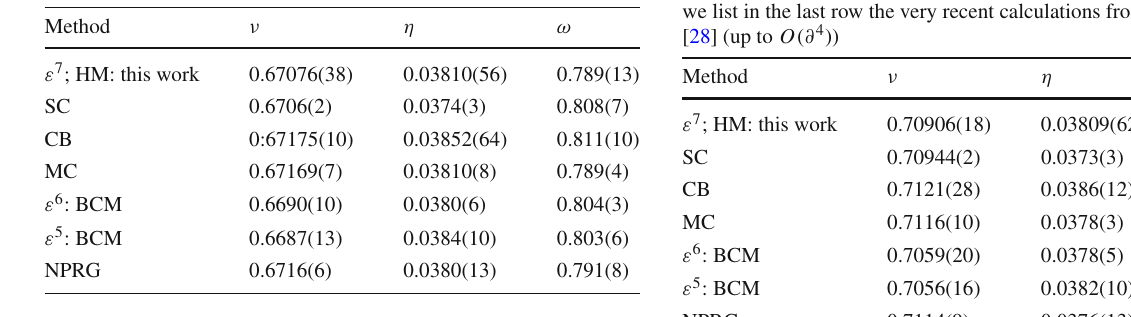
Table 3 The hypergeometric-Meijer ( ε 7 ;HM) resummation results for the exponents ν,η and ω of the O ( 2 ) -symmetric model. The recent SC results are taken from Ref. [54]. Other predictions are listed from conformalbootstrapcalculations[30,31]for ν and η [26],while ω result is taken from Refs. [25,32] and MC calculations from Ref. [21]. The six-loop BCM resummation ( ε 6 ) from Ref. [32] and the five-loops ( ε 5 ) from same reference. In the last row we add the NPRG results up to O (∂ 4 ) [28]